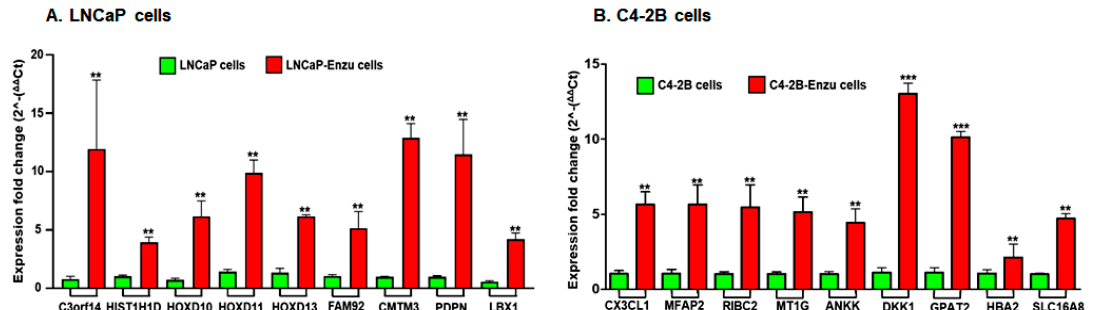
Figure 2. Real time PCR validation of genes in ( A ) LNCaP cells. Bars represent mRNA expression analysis of C3orf14 , HIST1H1D , HOXD10 , HOXD11 , HOXD13 , FAM92 , CMTM3 , PDPN , and LBX1 genes differentially expressed between LNCaP enzalutamide-resistant cells compared to the parental cell line. ( B ) C4-2B cells. Bars represent mRNA expression analysis of CX3CL1 , MFAP2 , RIBC2 , MT1G , ANKK , DKK1 , GPAT2 , HBA2 , and SLC16A8 genes differentially expressed between C4-2B enzalutamide-resistant cells compared to the parental cell line. The qRT-PCR data were analyzed using REST© (Relative Expression Software Tool), Qiagen, USA. Bar represents the standard error mean (SEM) for three biological and three technical replicates. ** p < 0.001, *** p < 0.0001 Control versus enzalutamide resistant cells.